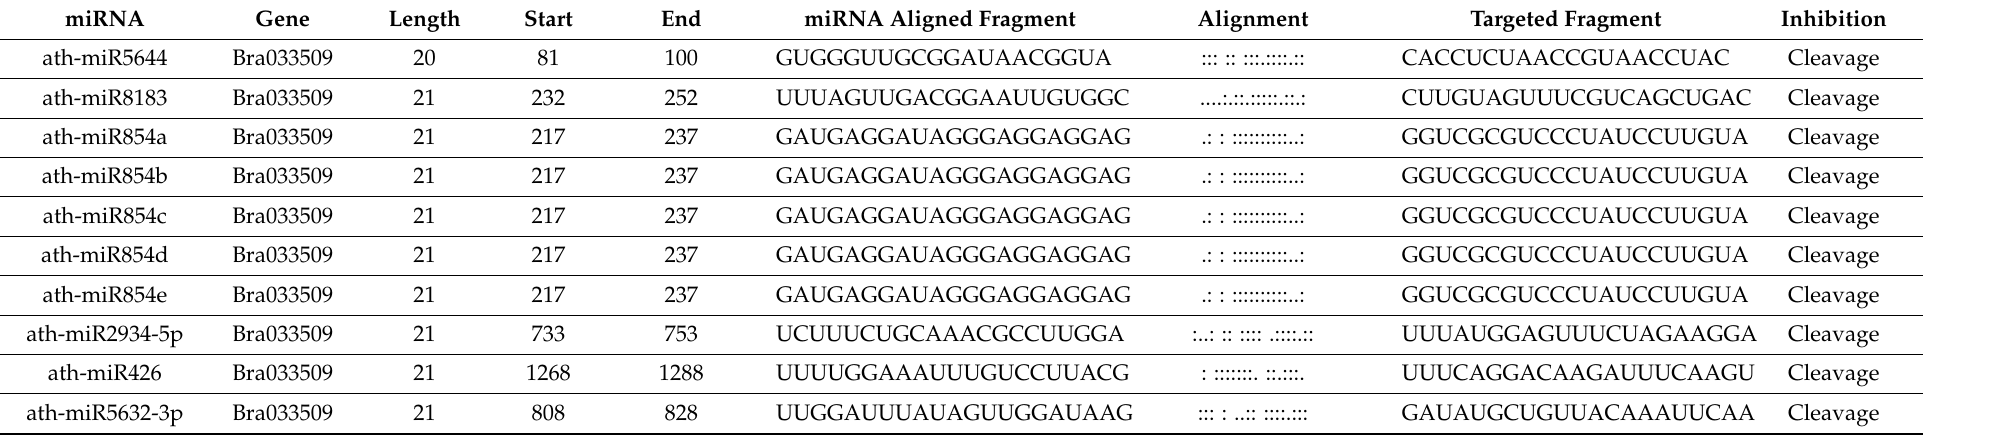
Table 1. Prediction of miRNAs targeting the BrCYP71A15 gene of Chinese cabbage. miRNA Gene Length Start End miRNA Aligned Fragment Alignment Targeted Fragment Inhibition 81 100 GUGGGUUGCGGAUAACGGUA Cleavage 232 252